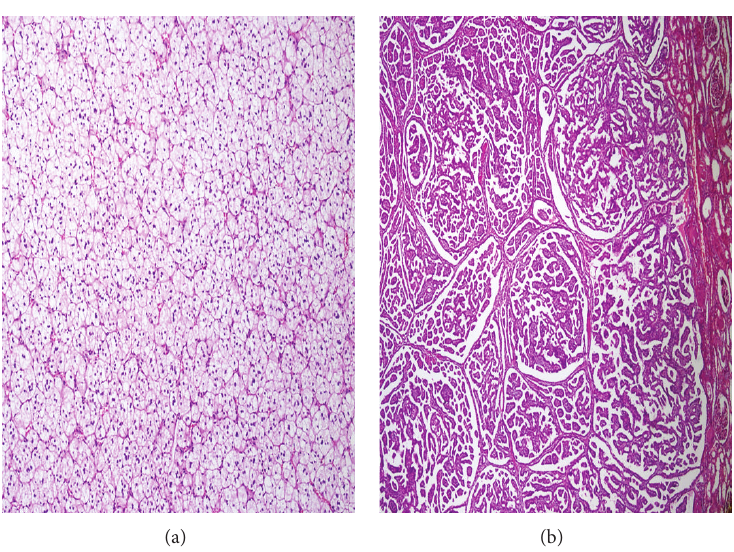
Figure 2: Microscopic images of clear cell RCC (a) and papillary type RCC